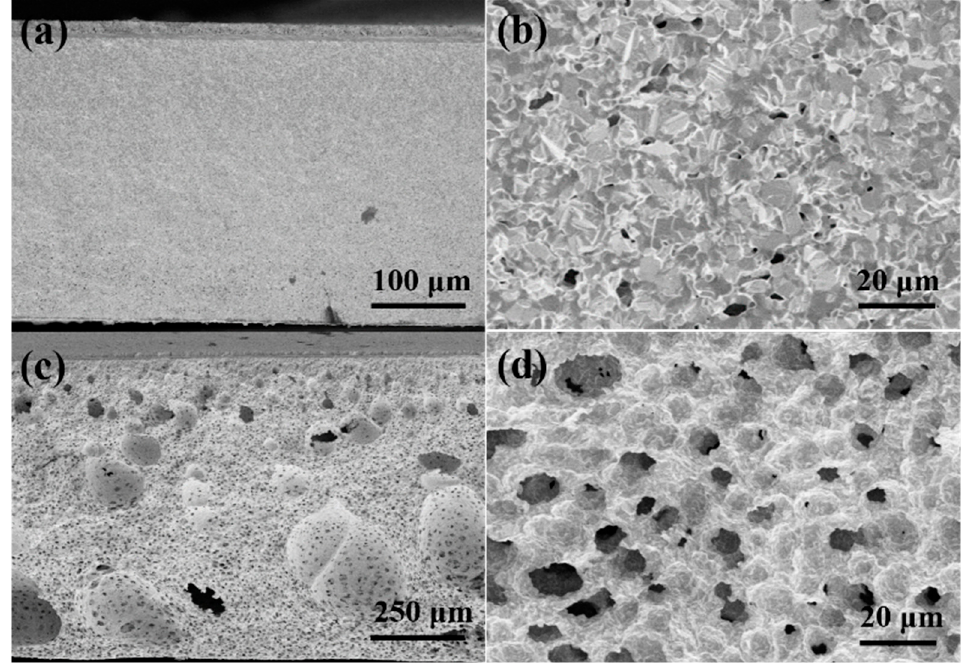
Figure 1. Cross-sectional FE-SEM images of hydrogen electrodes produced by tape-casting ( a , b ) and phase-inversion tape-casting ( c , d ) after calcining at 1400 °C for 5 h (not reduced).